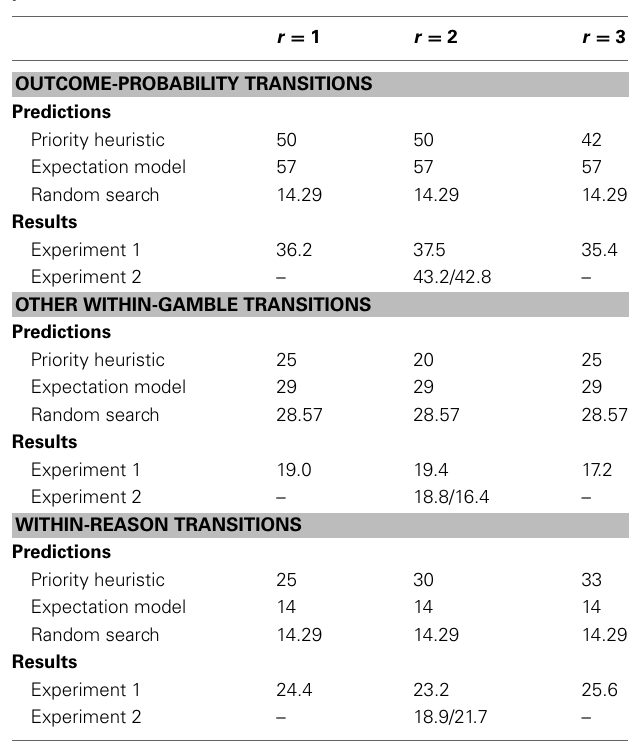
Table 2 | Predicted and observed transition percentages for the reading and choice phases combined in Experiments 1 and 2 (for Experiment 2, percentages are given separately for easy/difficult problems).